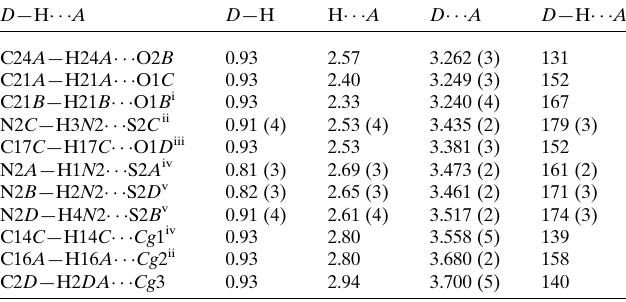
Table 3 Hydrogen-bond geometry (A˚ , (cid:2) ). Cg 1, Cg 2 and Cg 3 are the centroids of the C12 B –C17 B , C12 C –C17 C and C1 B – C6 B rings, respectively.